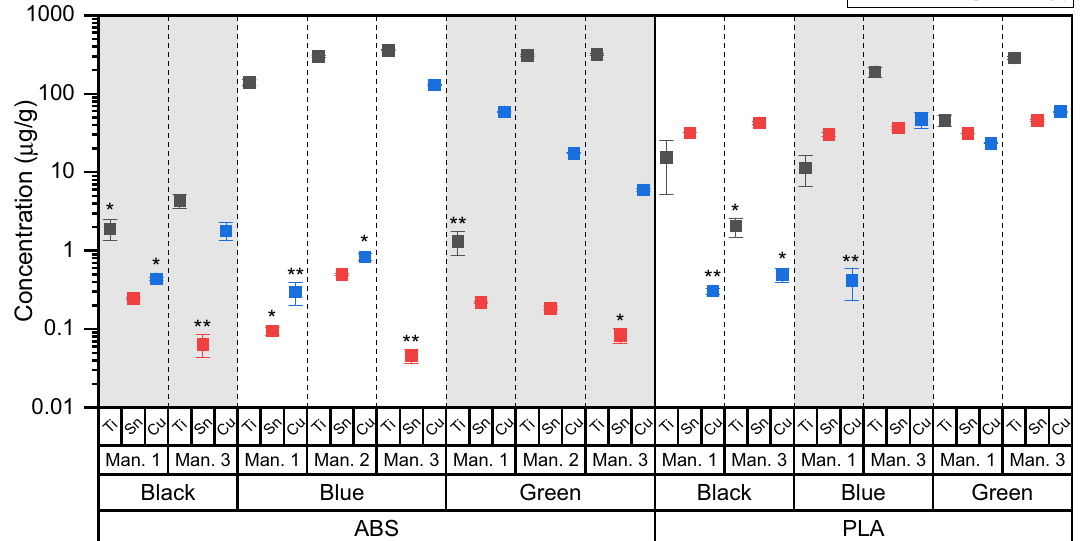
the standard error. Data below detection and quantification are included, but marked with asterisks (*below MRL, **below